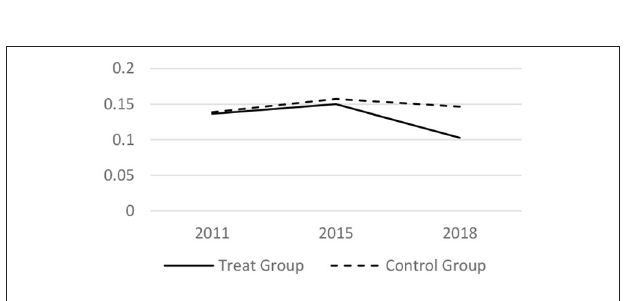
FIGURE 4 | Parallel trend of inexpatient frequency.